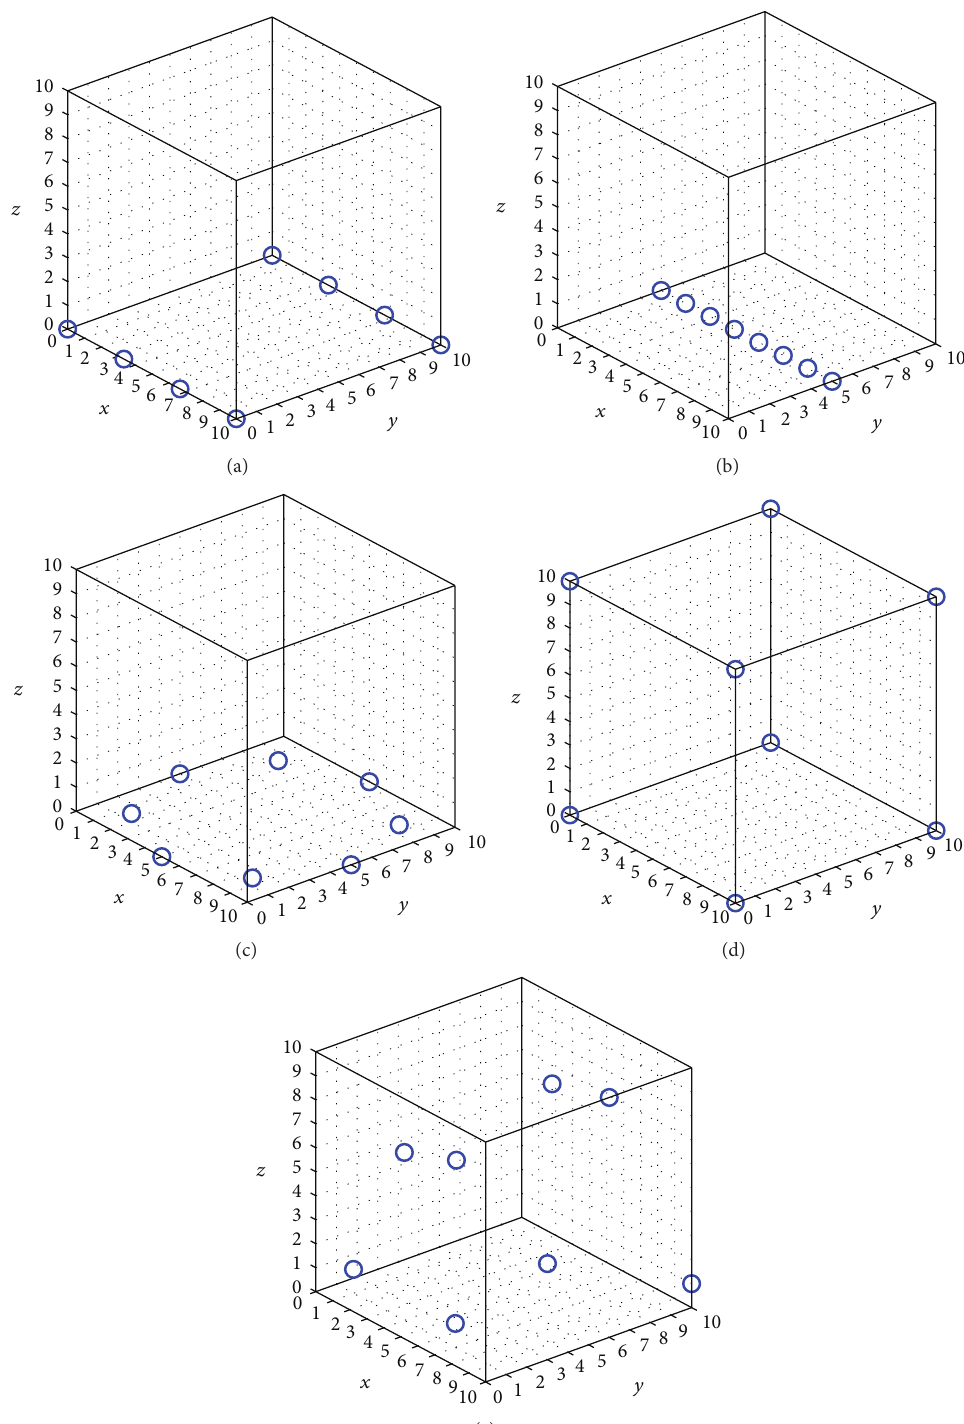
Figure 4: Distribution of 8 antennas on five different array configurations for UAVs formation flight: (a) planar, (b) linear, (c) circular, (d) cubic, and (e) 3D nonuniform optimized by